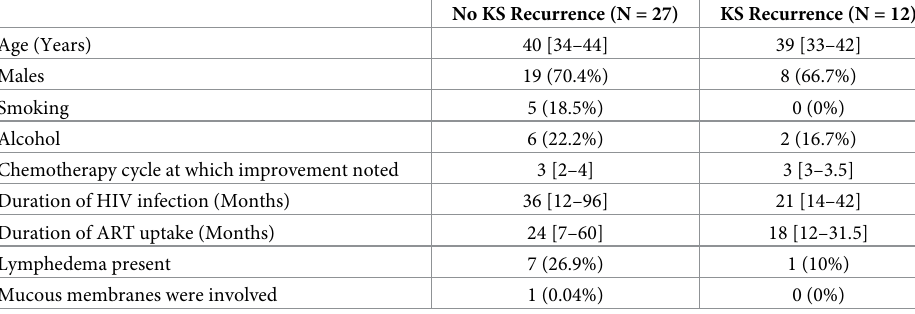
Table 1. Baseline characteristics of study participants by outcome.